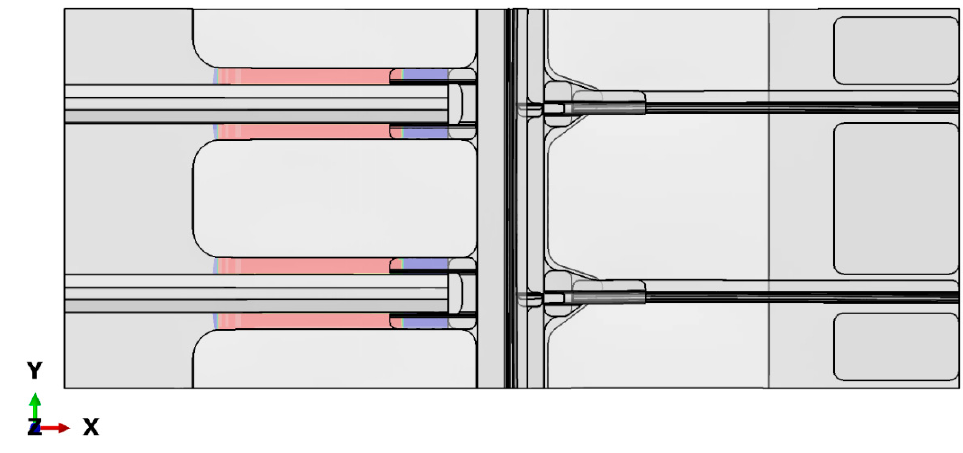
Figure 27. Omega joint configuration—delaminated area: load = 161 kN.